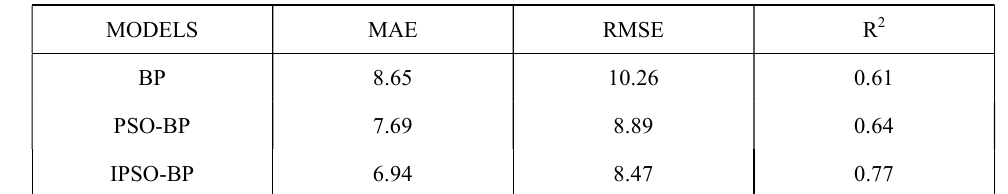
Figure 3. Model residual comparison